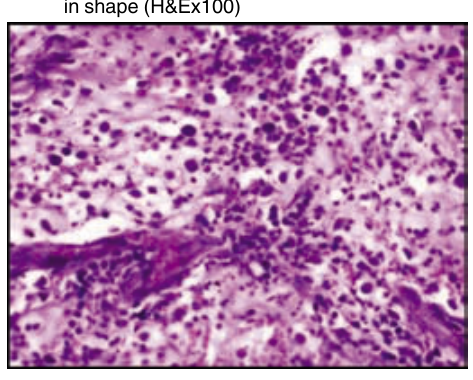
Fig.11. Inflammatory solid carcinoma – high infiltration of Tumour Associated Macrophages (H&Ex400)